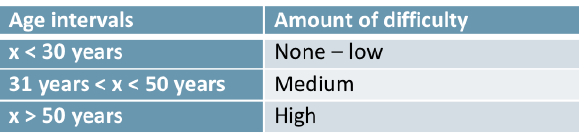
Table 3: Amount of diflculty due to